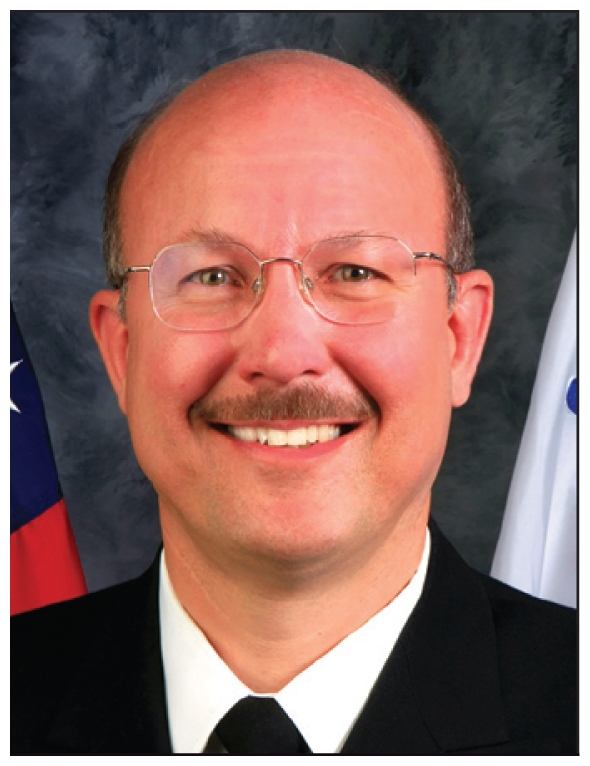
William S. Stokes